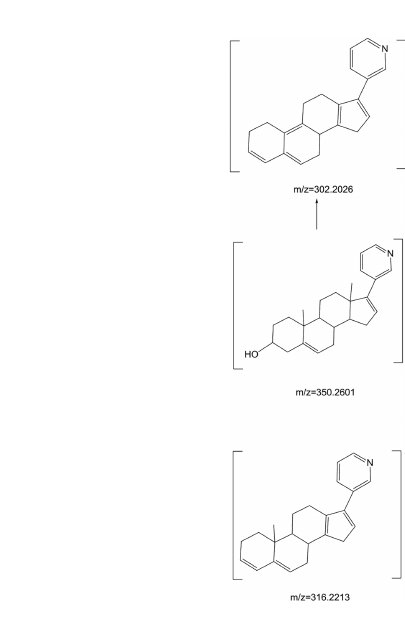
FIGURE 5 | The mass spectrometry fragmentation rule of